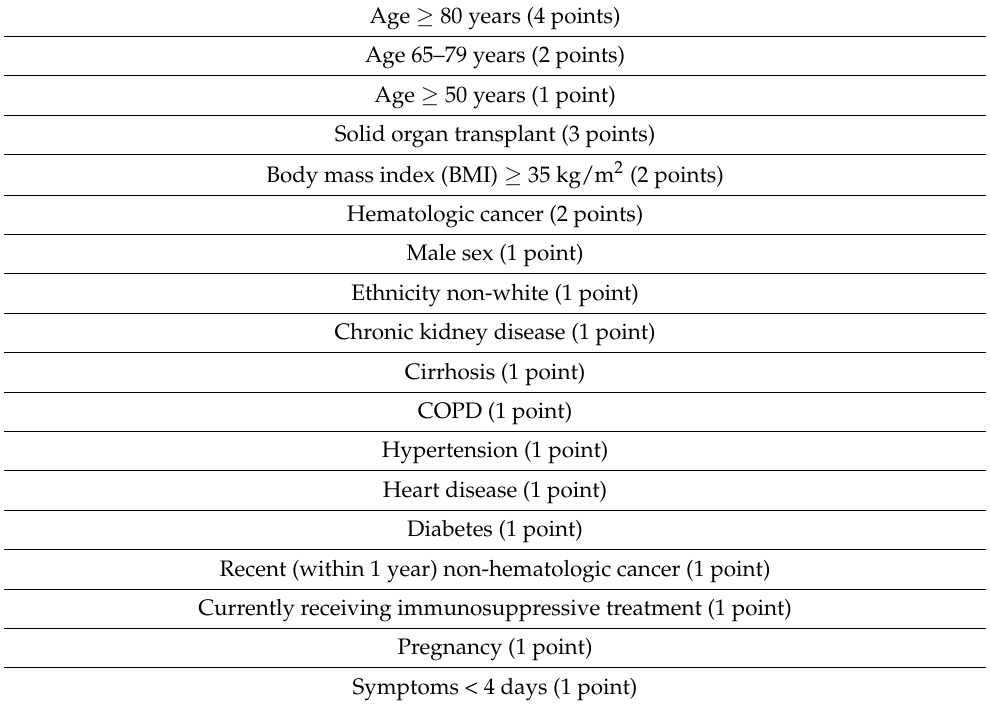
Table 2. Prioritization points for bamlanivimab administration. Priority for monoclonal antibody administration was based on a point system, where patients were given a range of 1 to 4 points depending on their age, gender, and concurrent